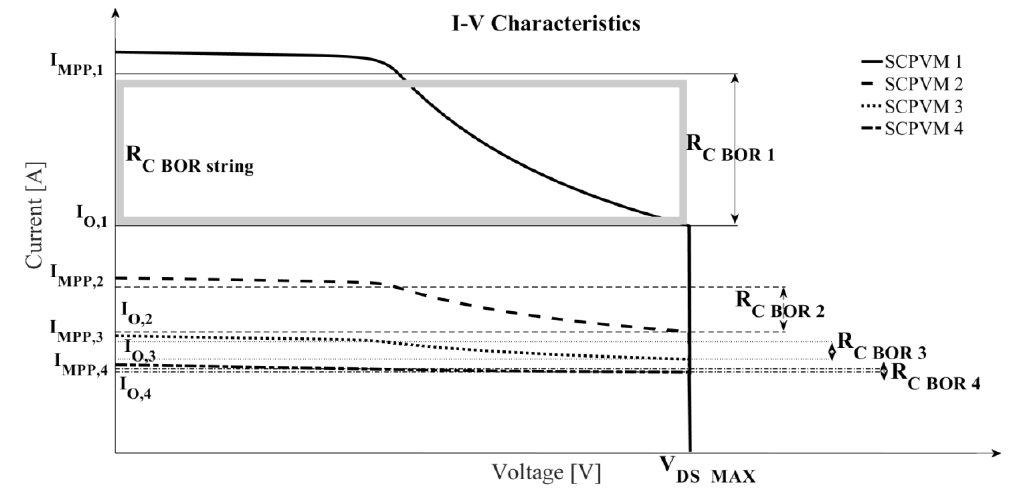
Figure 10. I-V characteristics of individual SCPVMs (Case B).